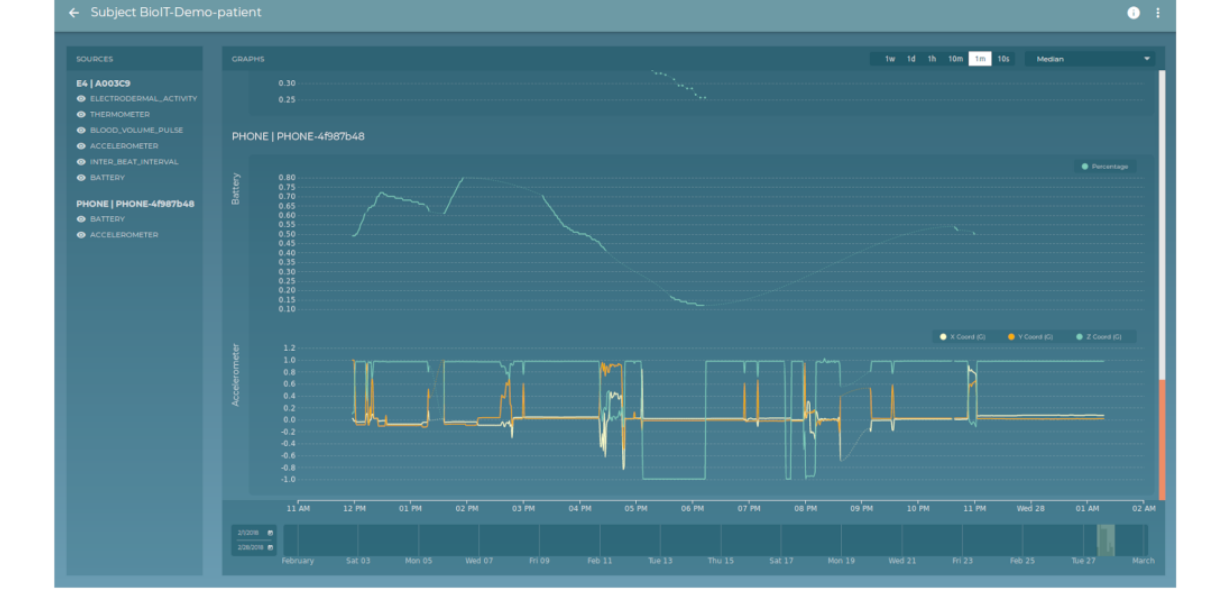
Figure 7. Participant data view (battery and accelerometer